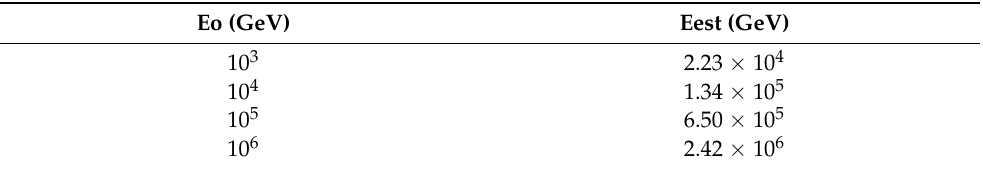
Table 3. “True” and estimated energies of primary gamma rays after passing through the electric field of 2.1 kV/cm